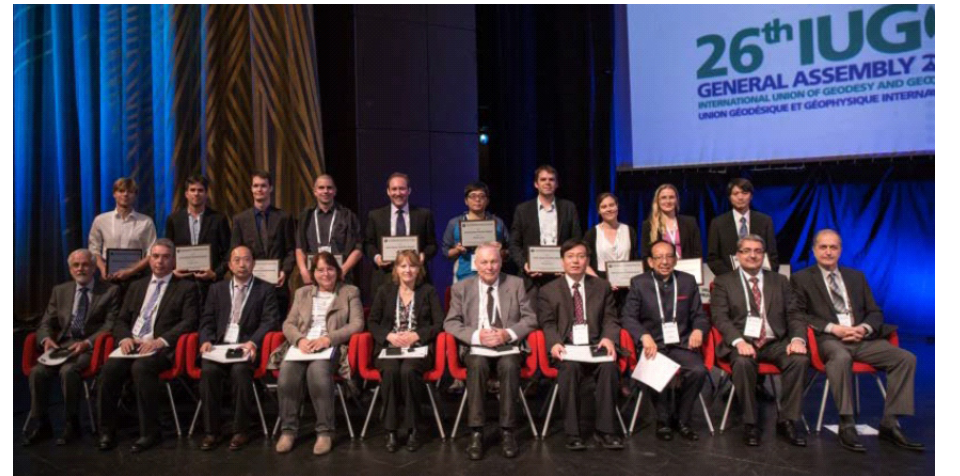
Figure 3. Award ceremony at the XXVI IUGG General Assembly, Prague, Czech Republic,